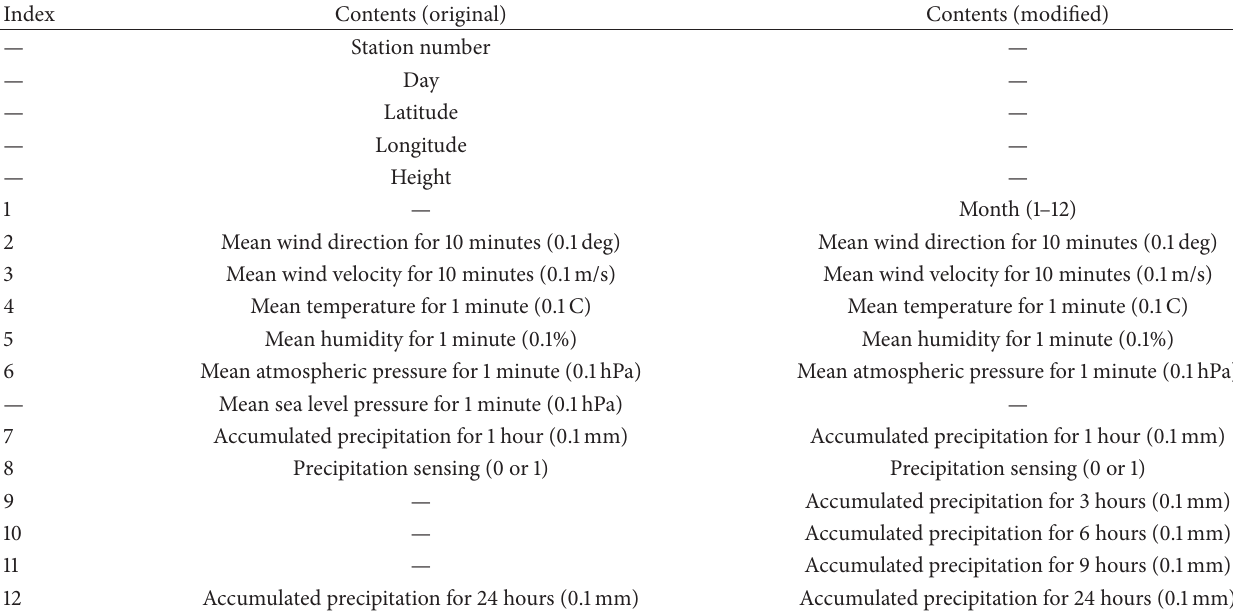
Table 1: Modified weather elements [4, 21].